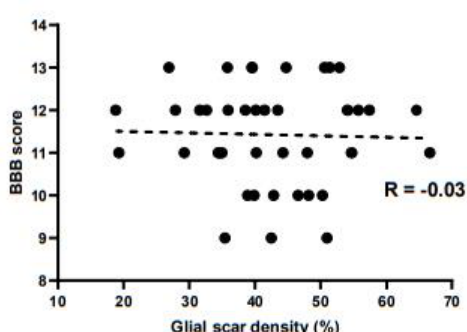
Figure 3. Effects of ahMNC transplantation on glial scar formation. ( A ) Glial scarring was measured using immunohisto- chemistry against GFAP. Red and yellow lines delineate the outer and inner contours of the glial scar, respectively. Scale bar = 1 mm. ( B ) The relative size of the glial scars was determined and then compared. ( C ) Correlation analysis revealed a significant negative relationship between the glial scar area and the BBB score. ( D ) However, there was no significant relationship between glial scar density and BBB score. Height = Average, Error bar = Standard Error. *, P < 0.05.